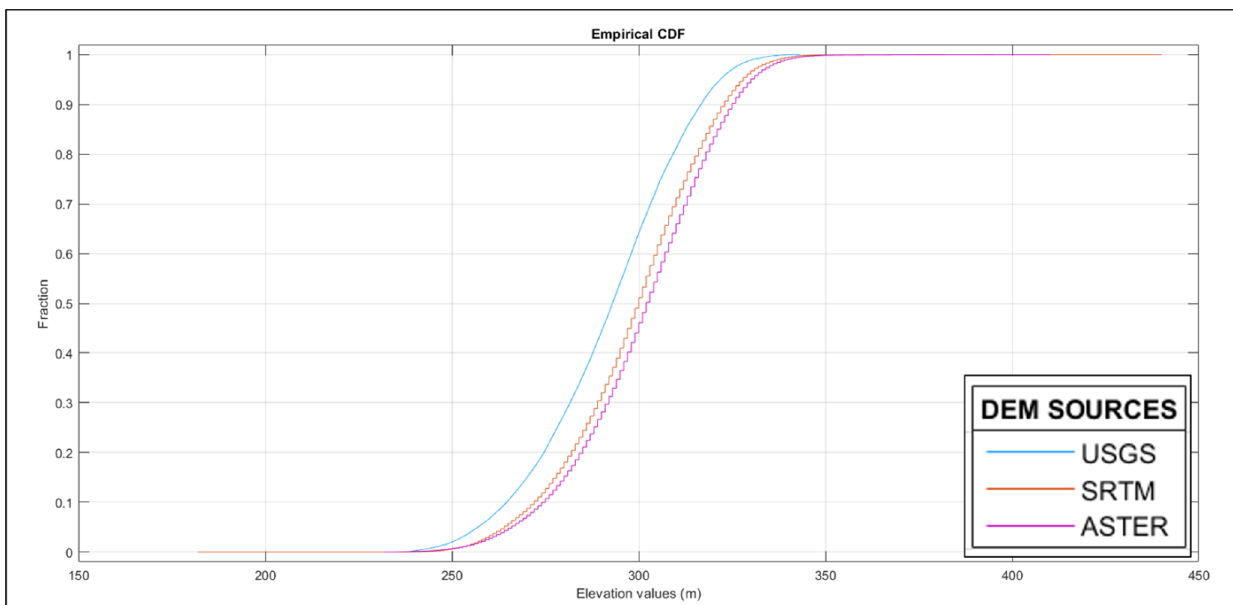
Figure 3. Digital Elevation Model showing the minimum and maximum range for different sources.